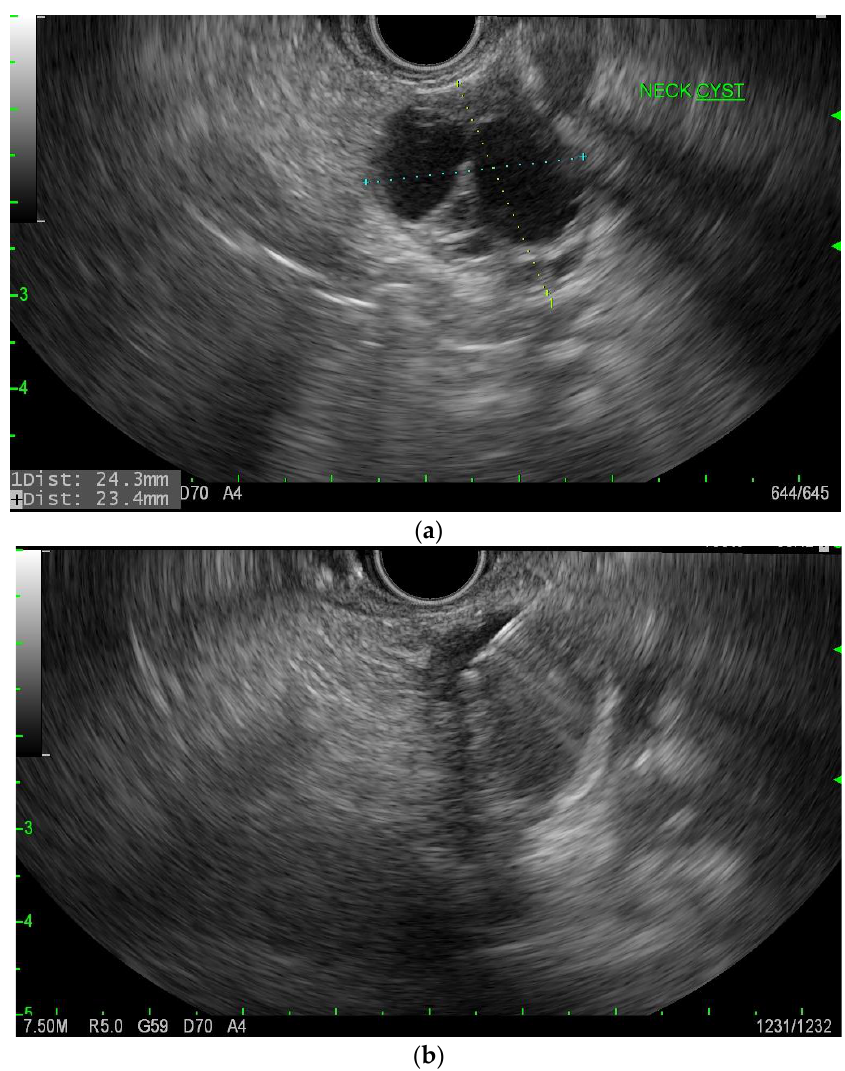
Figure 6. MRI of cNET of the pancreas.